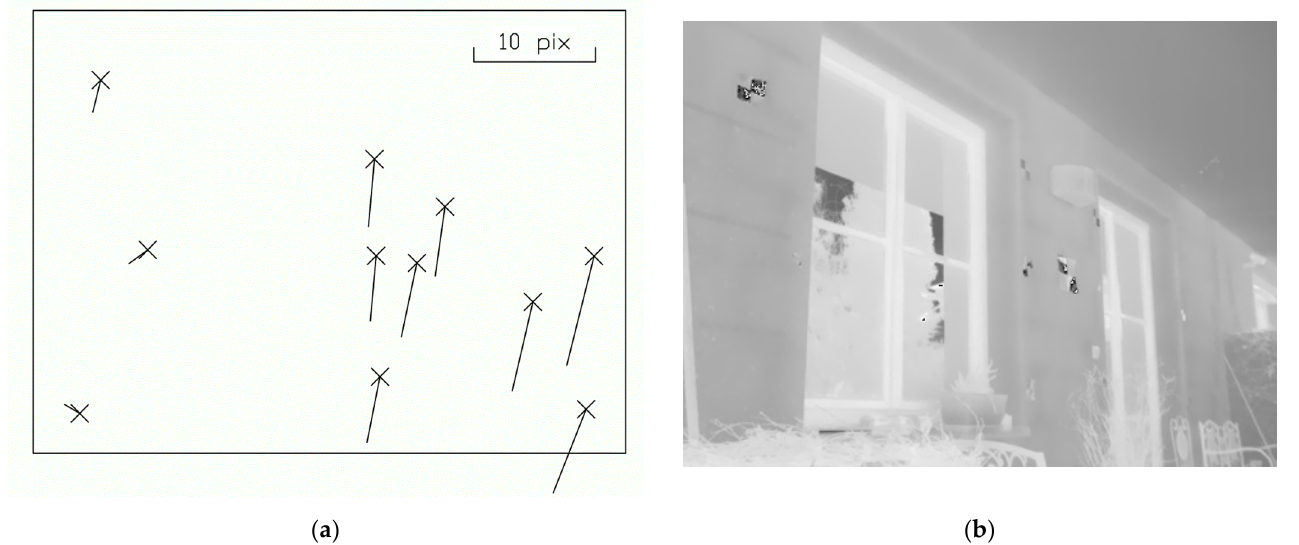
Figure 6. Residuals of the transformed TIR image to the corresponding RGB image using the transformation key computed on image pair 2 m from the façade: ( a ) residuals on the targets (the scale of the residuals were increased); ( b ) thermal infrared image.